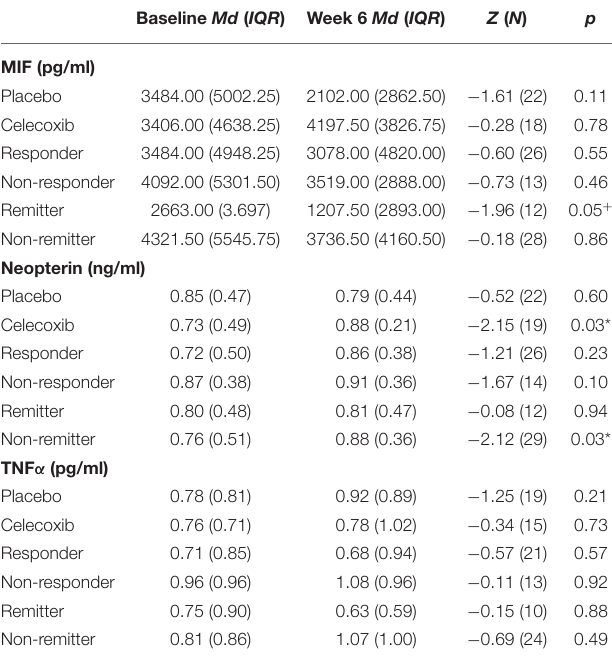
TABLE 2 | Baseline and endpoint biomarker levels according to treatment and response